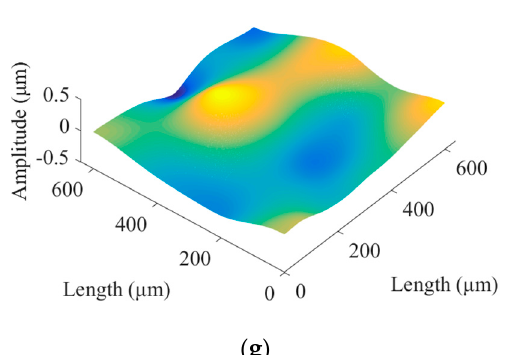
Figure 6. Time domain diagrams of BIMFs and residual. ( a ) BIMF1. ( b ) BIMF2. ( c ) BIMF3. ( d ) BIMF4.